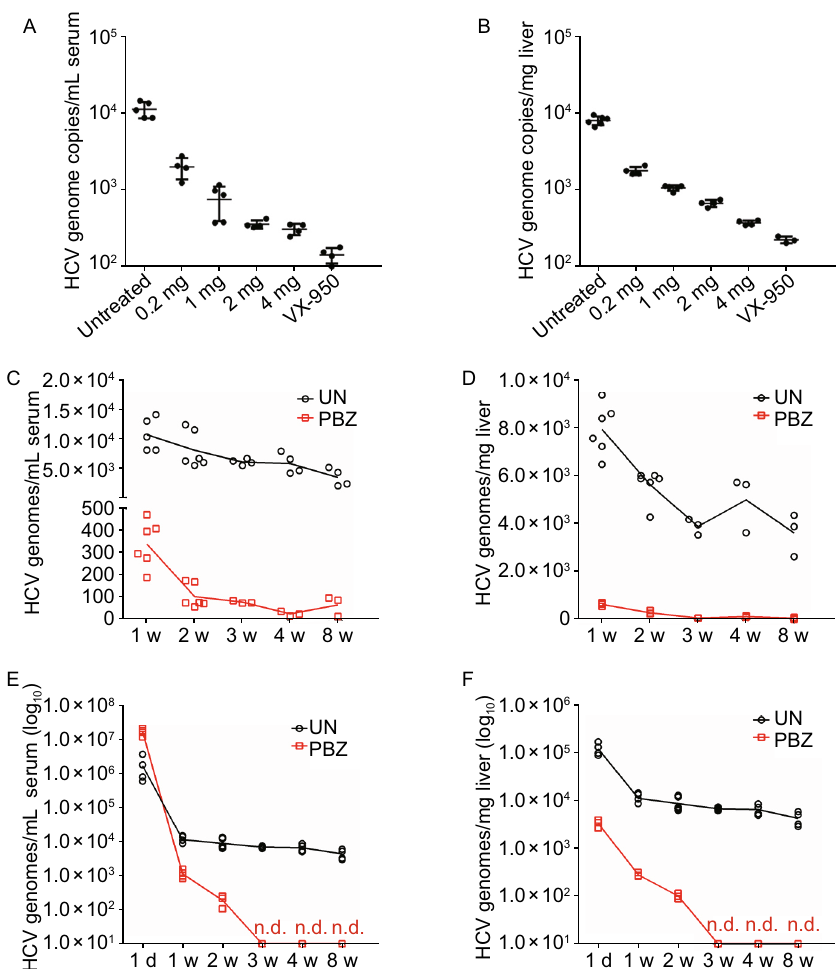
Figure 6. PBZ potently inhibits HCV in transgenic C/O Tg mice. (A and B) HCV RNA levels in serum (genome copies per milliliter of serum) and liver (genome copies per milligram of liver) from mice infected by HCV with subsequent 1 week treatments with various concentrations of PBZ. The treatment of VX-950 with the concentration of 20 mg/kg/d was used as a positive control. (C and D) HCV RNA levels in serum (genome copies per milliliter of serum) and liver (genome copies per milligram of liver) from mice infected by HCV with the treatments of 2 mg/kg/d PBZ for 1 week to 8 weeks. (E and F) HCV RNA levels in serum (genome copies per milliliter of serum) and liver (genome copies per milligram of liver) from mice which PBZ treatment delayed the establishment of HCV infection in mice pretreated for 1 week before infection con fi rming the ability of this drug to inhibit HCV infection in vivo . Samples were analyzed by qRT-PCR. All results are graphed as the mean ± SD for triplicate samples. The data presented are representative of three independent